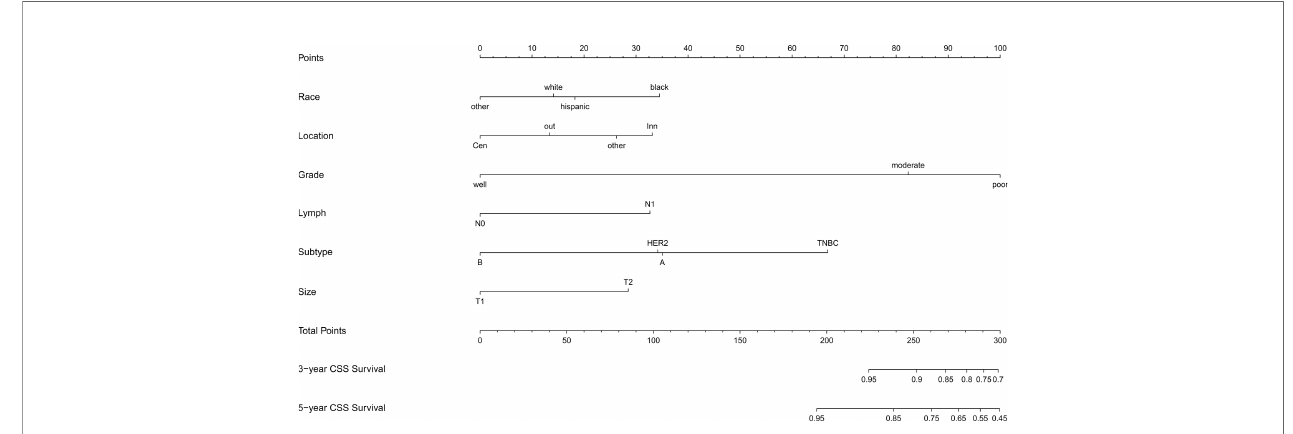
FIGURE 3 | Nomogram for predicting the 3-,5- year CSS in young women with early-stage breast cancer. Note: other: de fi ned as the non-Hispanic Asian/Paci fi c Islander and American Indian/Alaska Native; CSS, cancer-speci fi c survival; A, Luminal A; B, Luminal B; TNBC, triple-negative breast cancer; HER2, Her-2